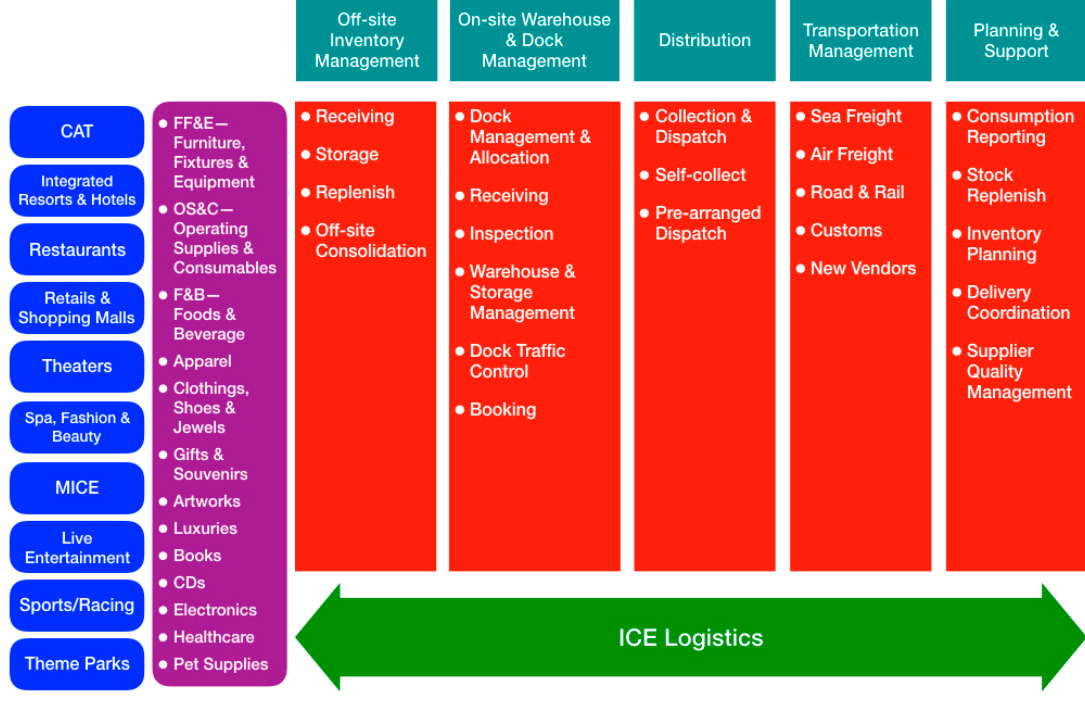
Figure 1. ICE logistics operations.